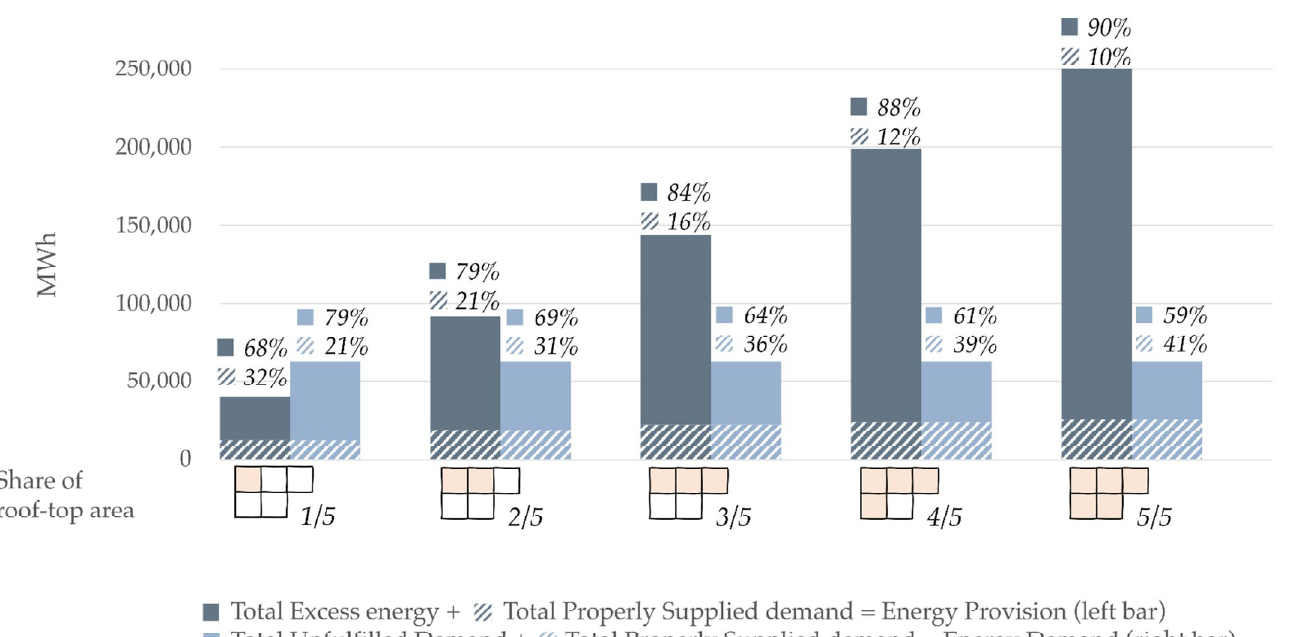
Figure 10. Spatiotemporal results of heat demand and solar thermal energy provision in the entire case study area (own